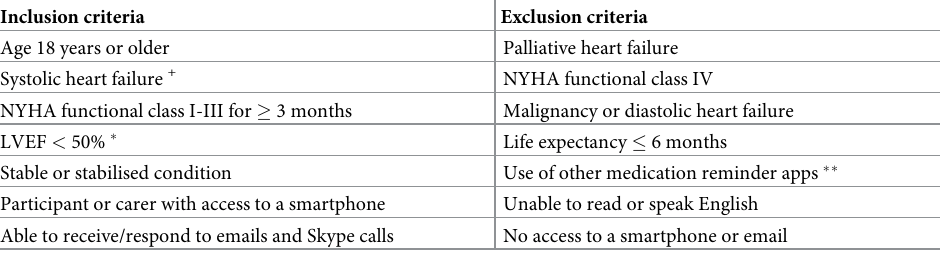
Table 1. Eligibility